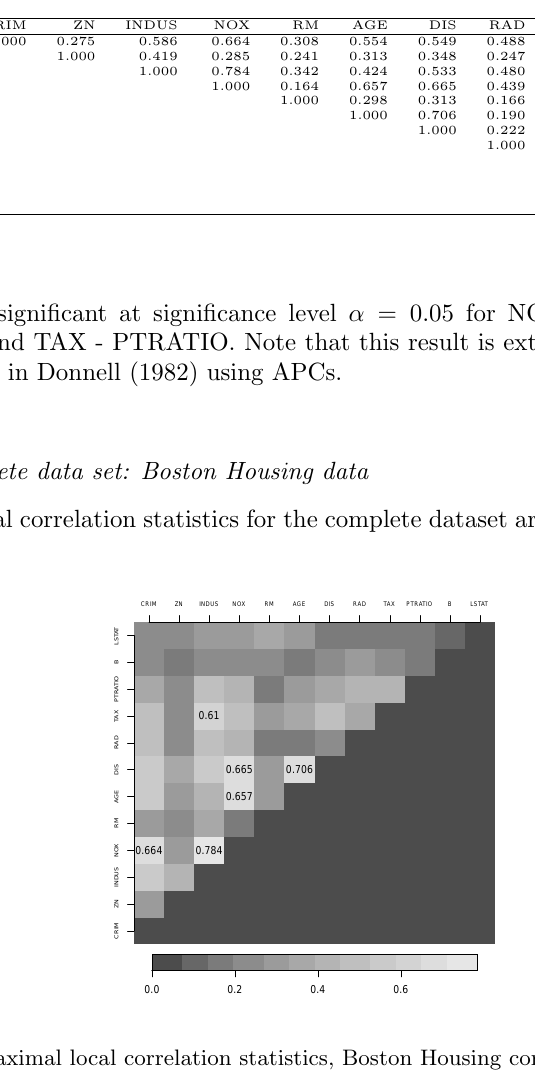
Maximal local correlations, Boston Housing Complete data